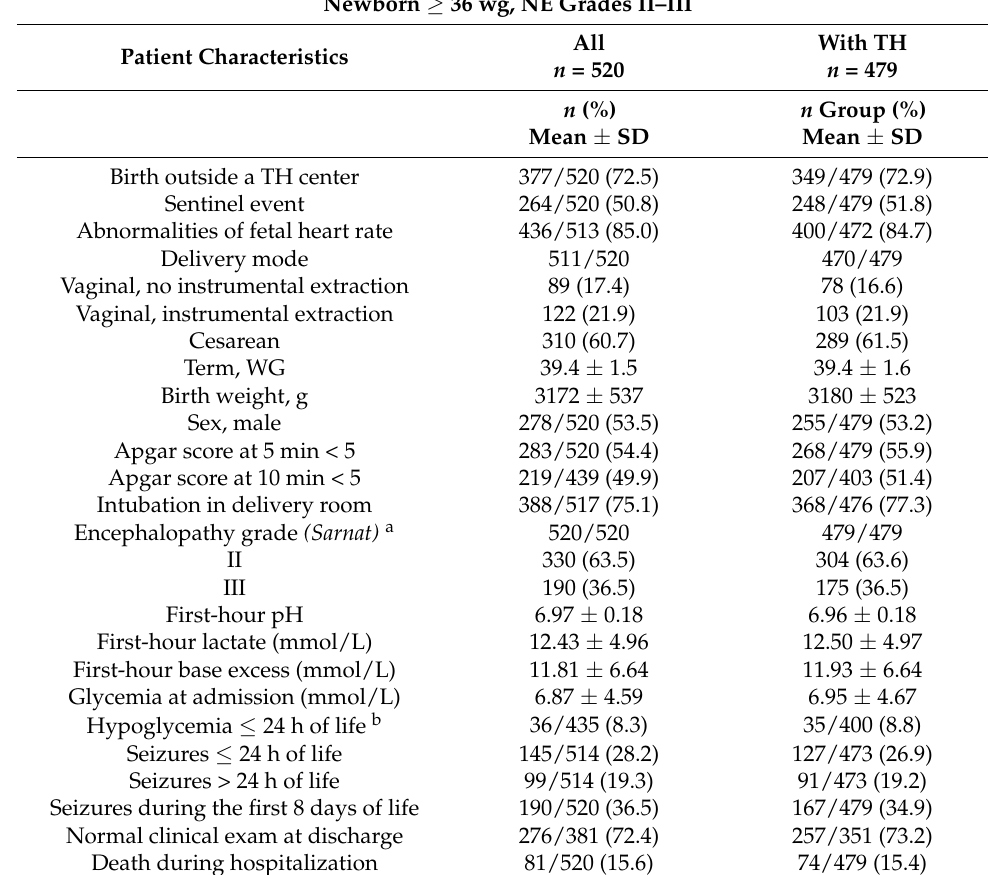
Table 1. Characteristics of the